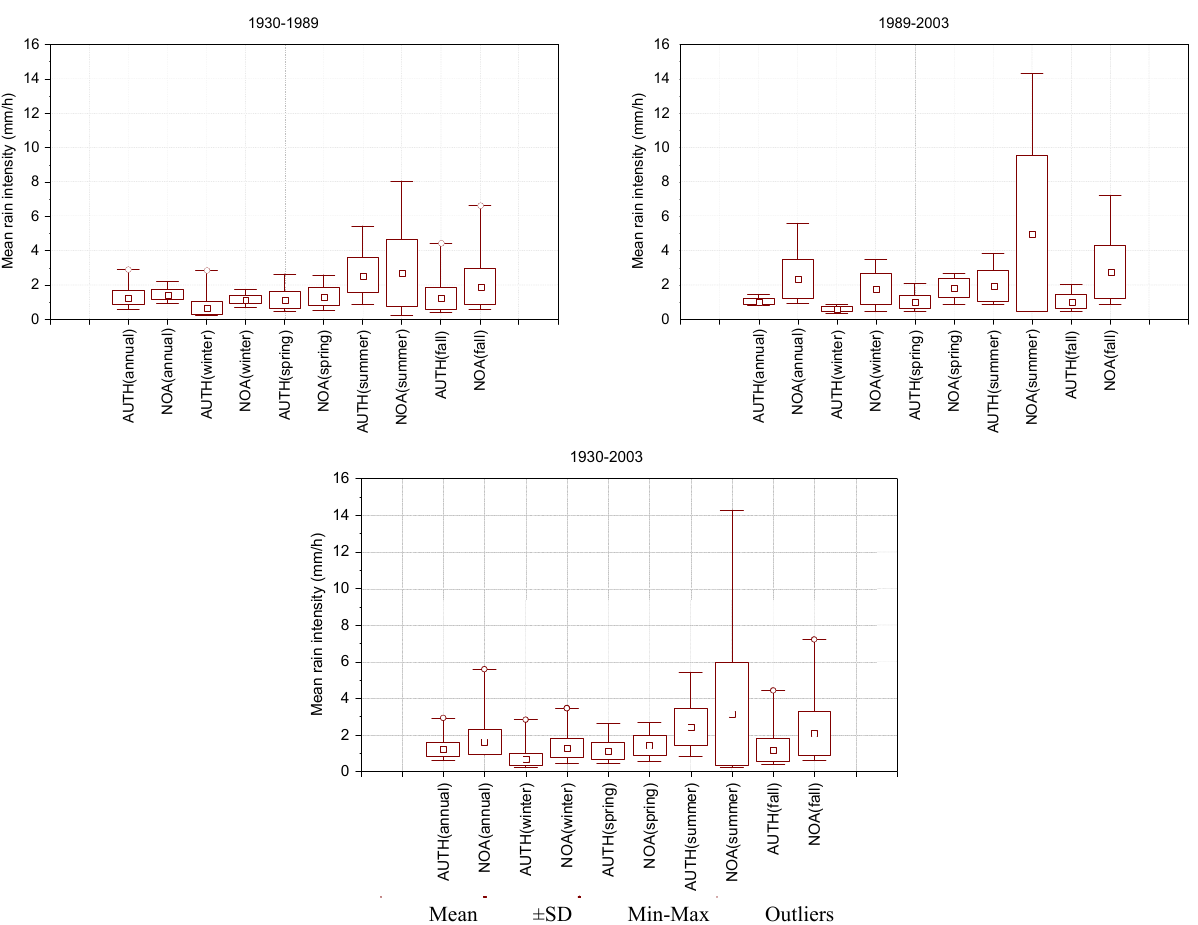
Fig. 3. Box and Whiskers plots for the annual and seasonal mean rain intensity within the sub periods: 1930–1989, 1989–2003 and 1930– Figure 3 . Box & Whiskers plots for the annual and seasonal mean rain intensity within the sub 2003 for NOA and periods: 1930-1989, 1989-2003 and 1930-2003 for NOA and AUTH.